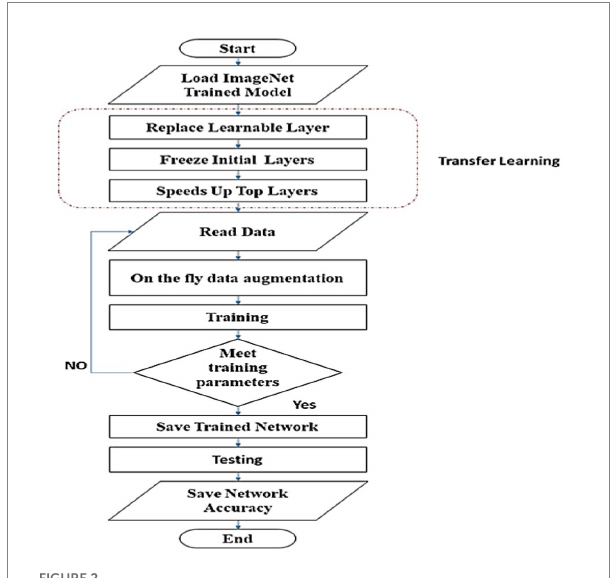
FIGURE 2 Flowchart of training and testing scheme to rank examined networks, according to their classification accuracy.